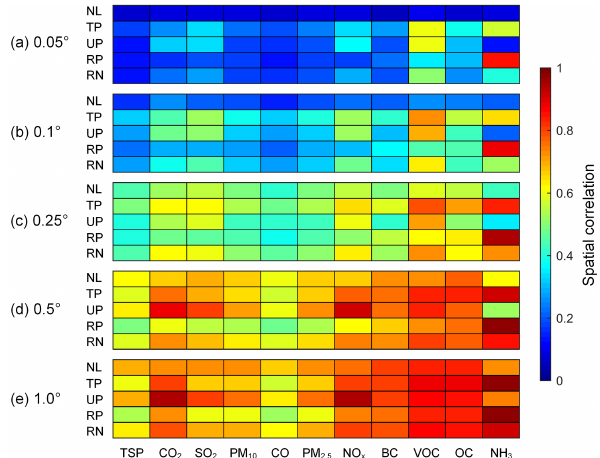
Figure 8. Spatial correlations between gridded emissions of HB-EI and various spatial proxies at the resolutions of (a) 0.05 ◦ , (b) 0.1 ◦ , (c) 0.25 ◦ , (d) 0.5 ◦ , and (e) 1.0 ◦ . The pollutants are sorted ac- cording to descending contribution of point-source emissions from left to right. NL: nighttime light (http://ngdc.noaa.gov/eog/dmsp/ downloadV4composites.html), TP: total population, UP: urban pop- ulation, RP: rural population (population data (Oak Ridge National Laboratory, 2013) with urban–rural extents (Schneider et al., 2009), RN: road network (Zheng et al.,